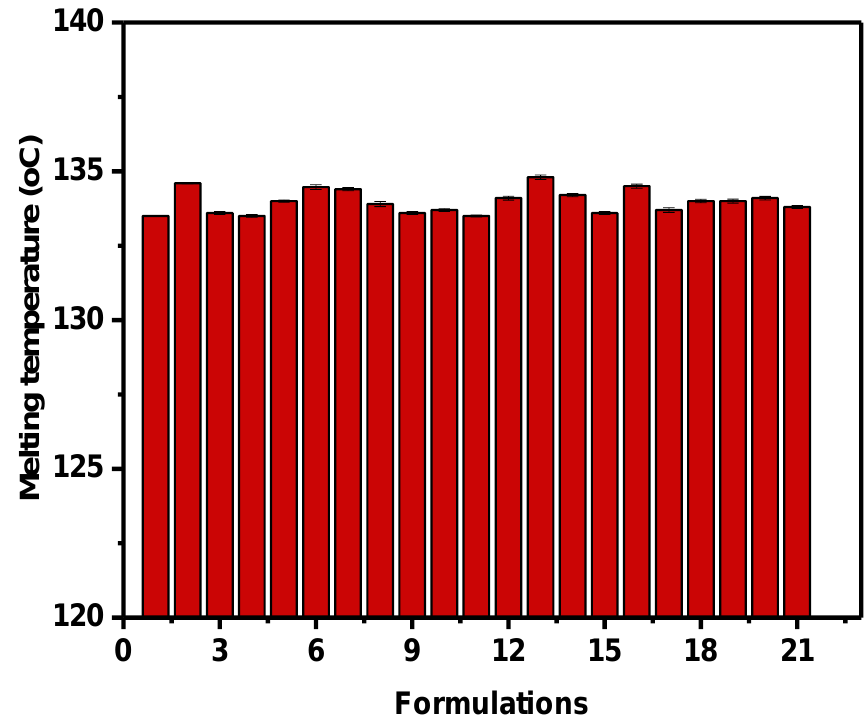
Figure 1. DSC-derived melting temperature (T m ) of HDPE/filler composites .